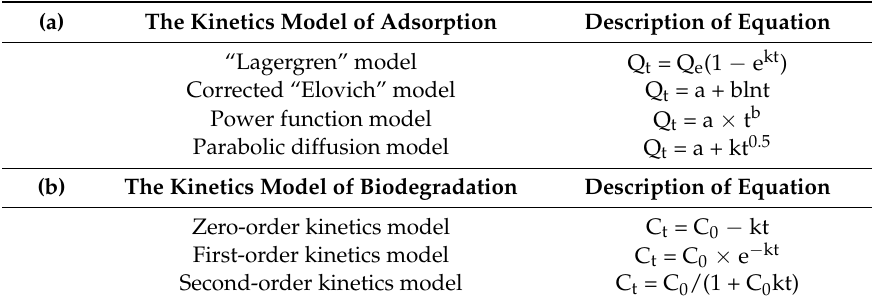
Table 3. The kinetics models of adsorption and biodegradation. ( a ). The kinetics models of adsorption; ( b ). The kinetics models of biodegradation.